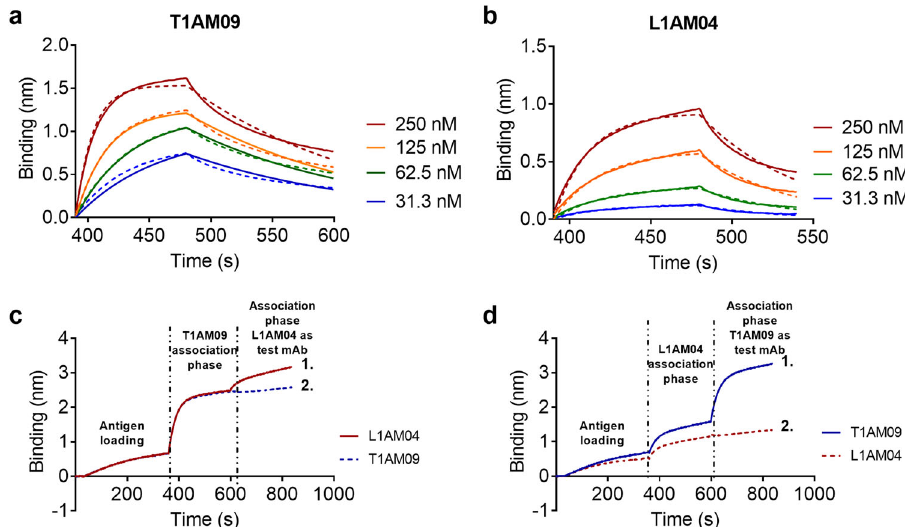
Fig. 4 Bio-Layer Interferometry (BLI) and epitope binning quantitate af fi nity of mAbs to AM. Binding curve of a T1AM09, and b L1AM04, generated by BLI - solid lines represent experimental data and dashed lines are statistically fi tted curves. Two-phase binding experiment assessing c T1AM09 and d L1AM04 competition with each other. Solid line 1 shows the association curve with test mAb. Dashed line 2 is the association curve with self-control. .